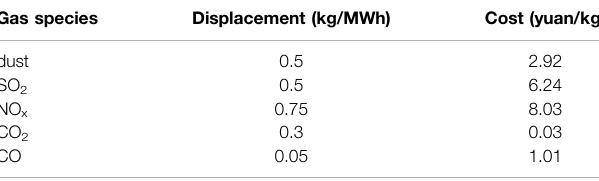
TABLE 3 | Type and cost of emissions.